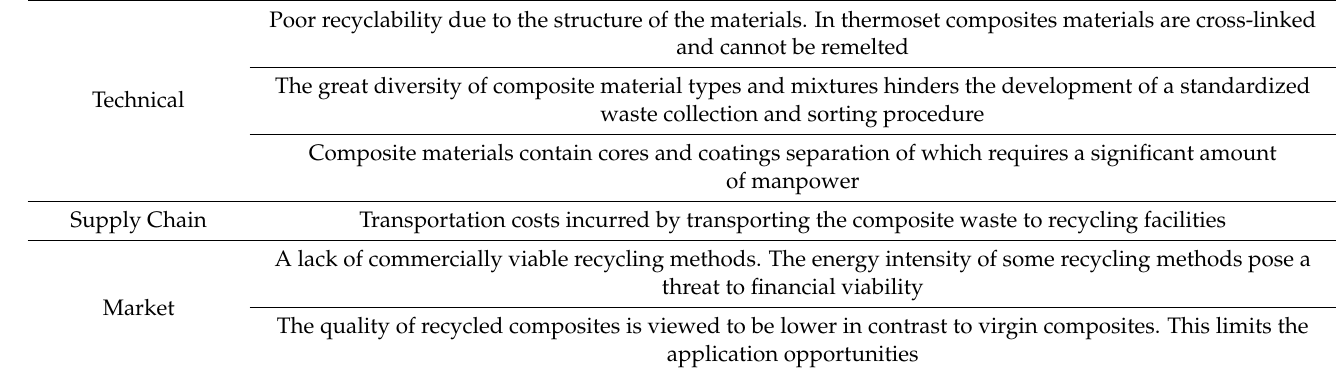
Table 1. Technical and economic barriers to composites